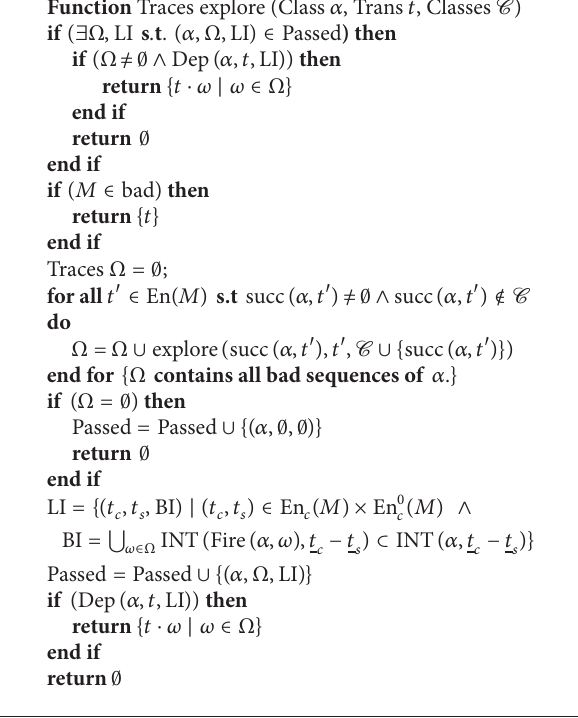
Algorithm 2: On-the-fly algorithm for the safety control of TPN-Part